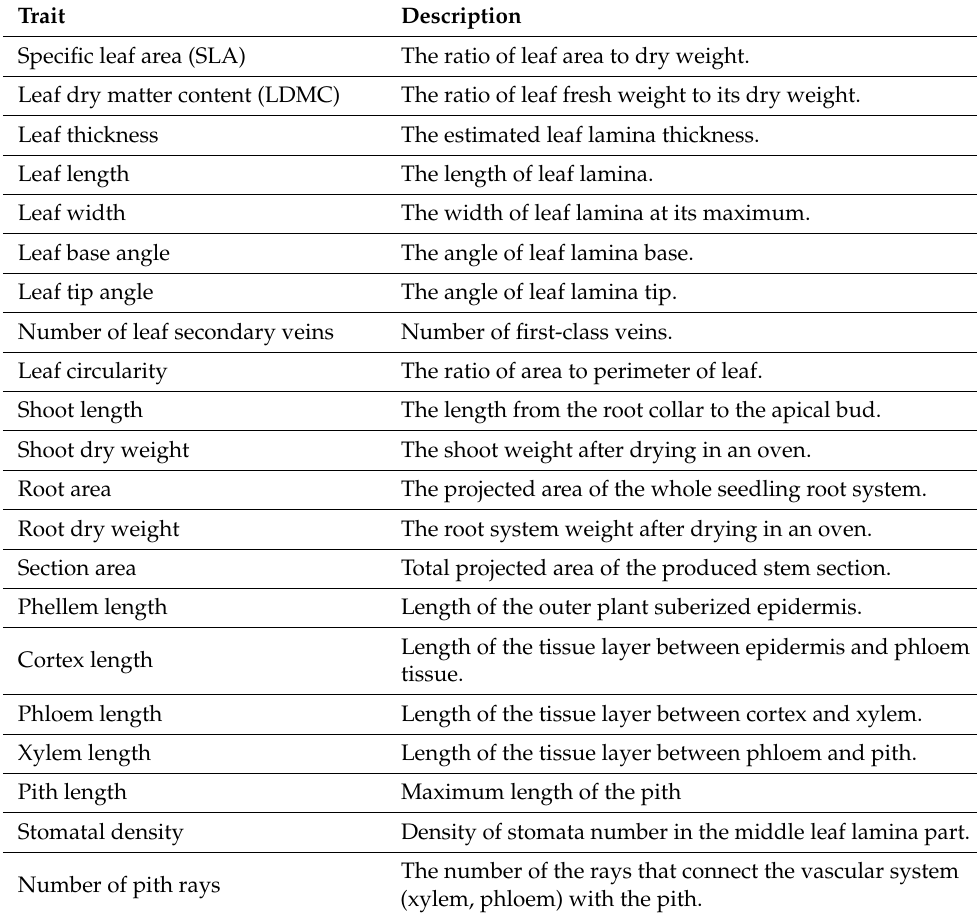
Table 1. Definition of the measured